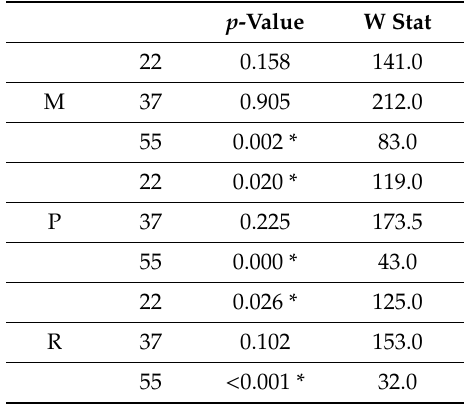
Table 8. Comparison of TVCs of mud samples between SS and AS. The table provides p -values and W statistics for the Wilcoxon signed rank test. Significant p -values ( < 0.05) are marked with asterisk (*). M—maturing mud, P—peloid, R—regenerating used